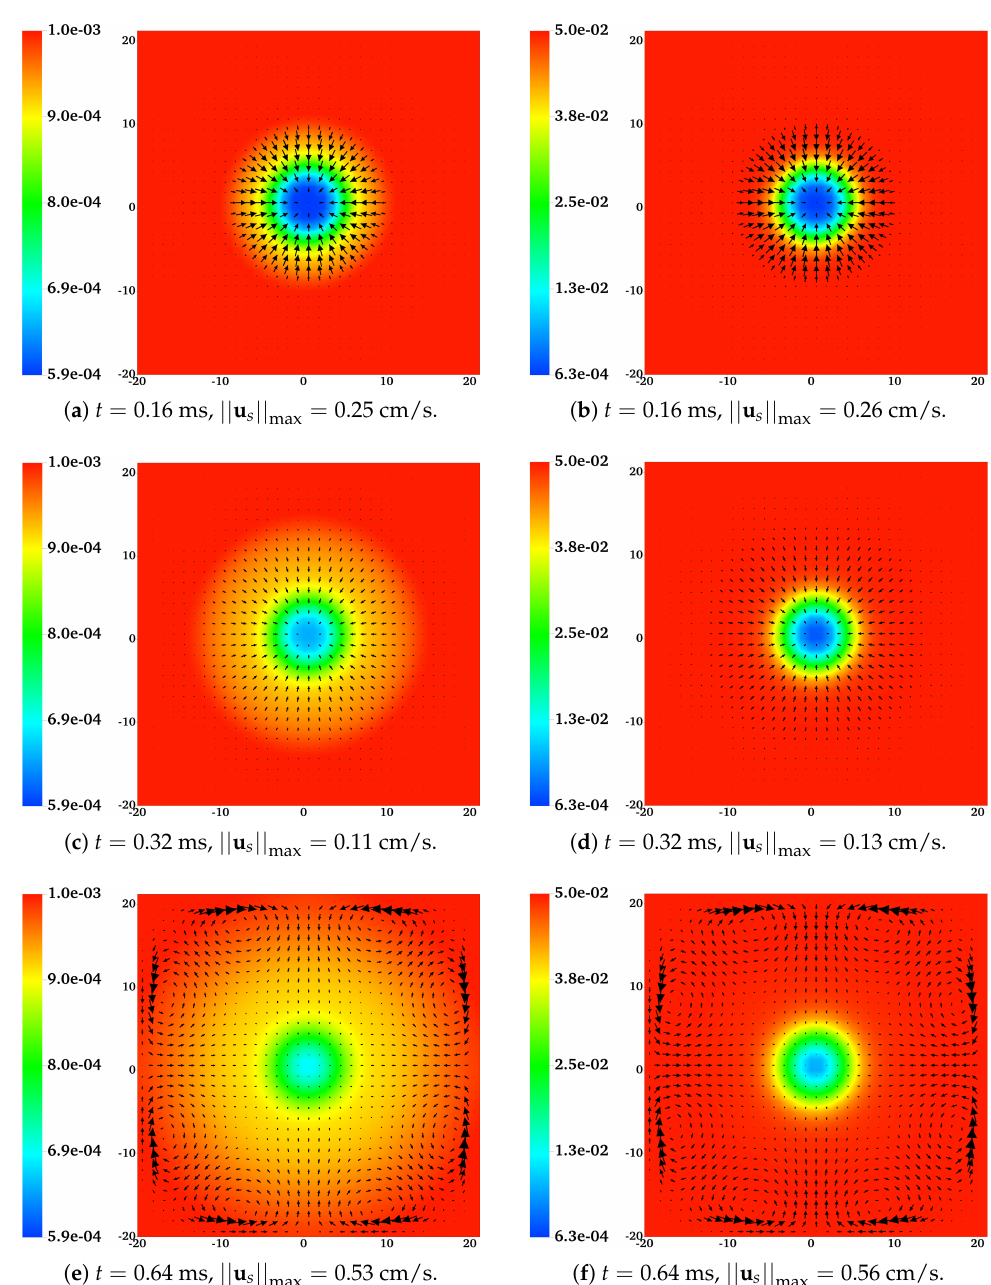
Figure 3. The concentration of dissolved sodium ions C Na and the solvent velocity field u s at different = 0.001 M and ( b , d , f ) C ∗ = 0.05 M. All vectors have the same times for ( a , c , e ) C ∗ Na Na